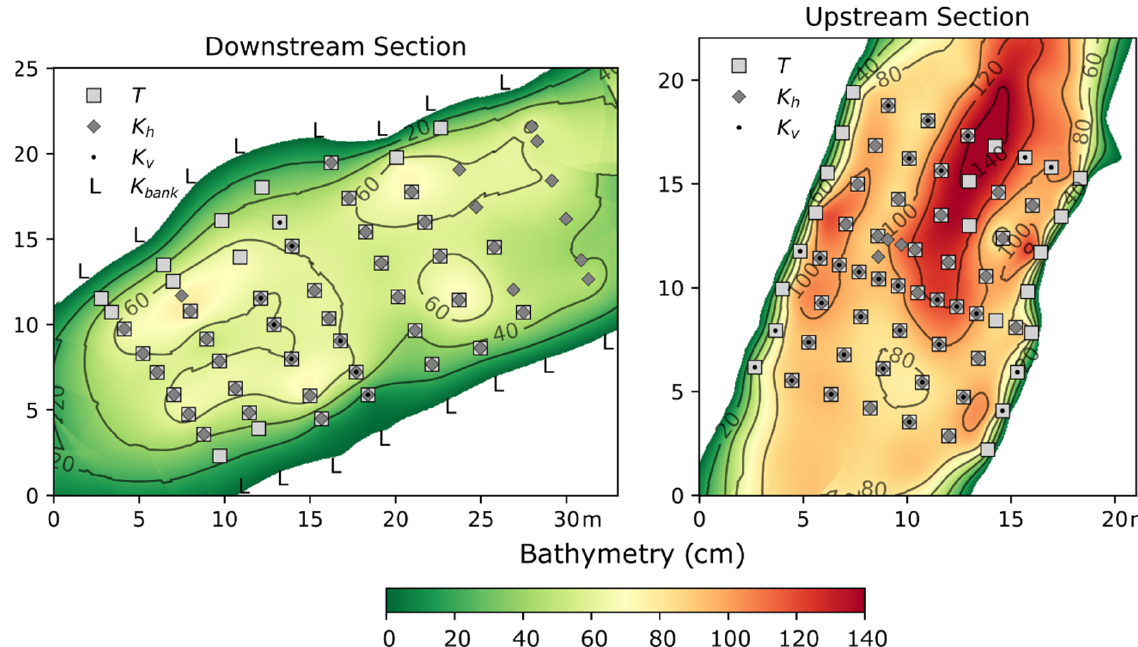
Figure 2. Bathymetry maps with an indication of the locations of measured temperature profiles ( T ), slug tests ( K h ), standpipe tests ( K v ) and L-shaped standpipe tests ( K bank ) for both the downstream and upstream